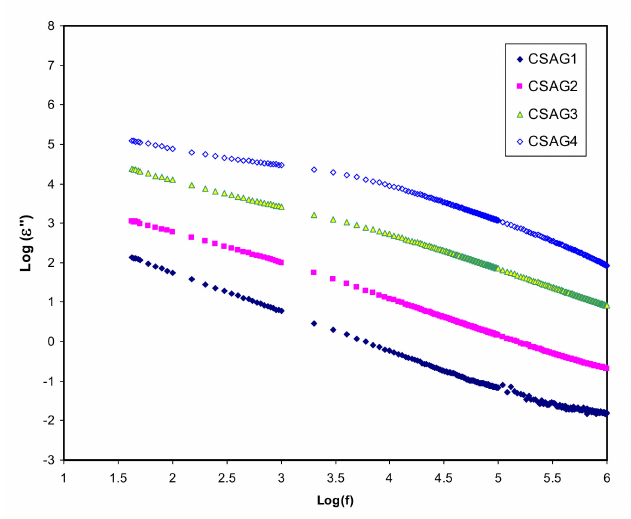
Figure 3. Dielectric loss ( ε ” ) variation against frequency of electrolyte samples (CSAG1–CSAG4) at ambient